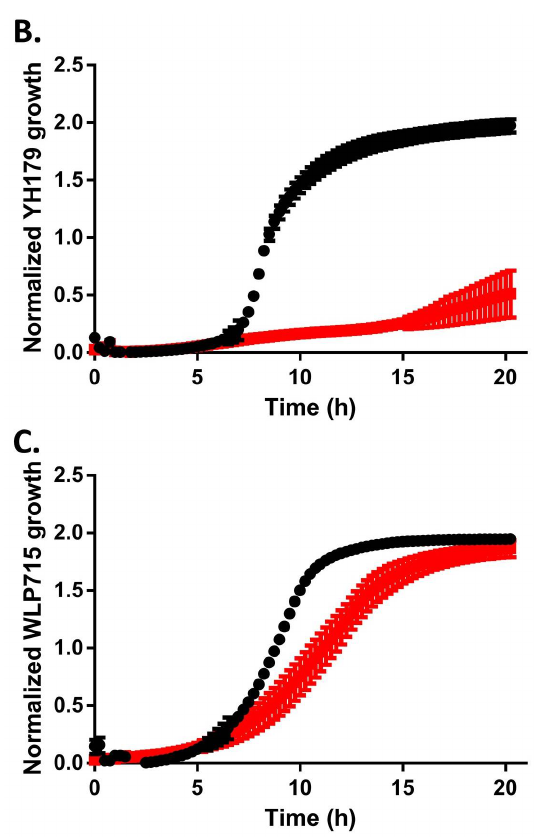
Figure 2. YH178 and YH179 grow poorly in the presence of maltose. YH178 ( A ), YH179 ( B ), and S. cerevisiae WLP715 ( C ) were grown to saturation overnight in YPD medium, back-diluted into YPD (black) or YPM (red) medium, and grown overnight in a 96-well plate. Growth was monitored by recording the OD 660 of each culture and is plotted vs. time. The plotted points are the averages of three independent experiments, and the error bars are the standard deviations.